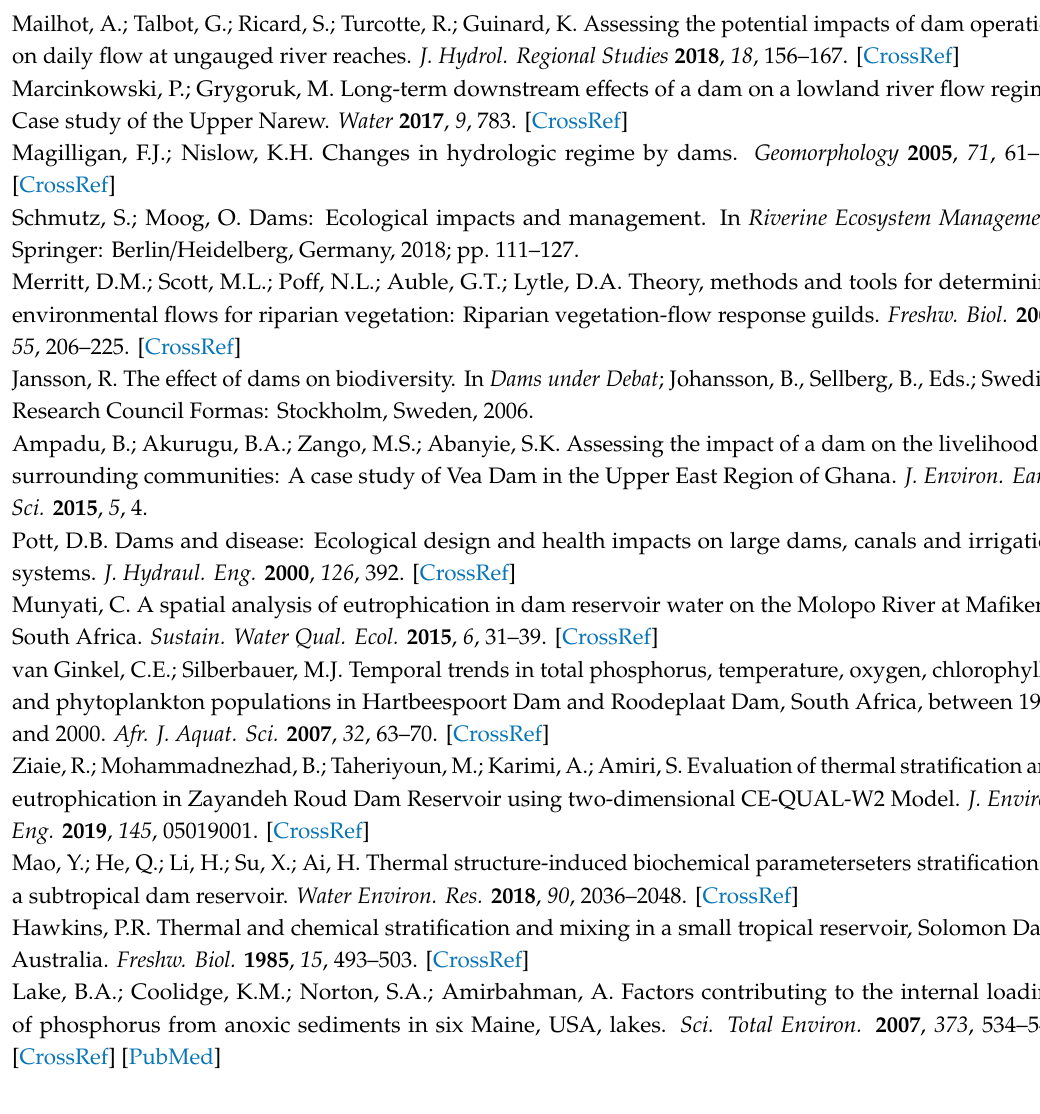
Figure S1: Langelier-Ludwig classification diagrams of Ridracoli and Capaccio waters; Table S1: Major and trace element concentrations of Ridracoli and Capaccio water